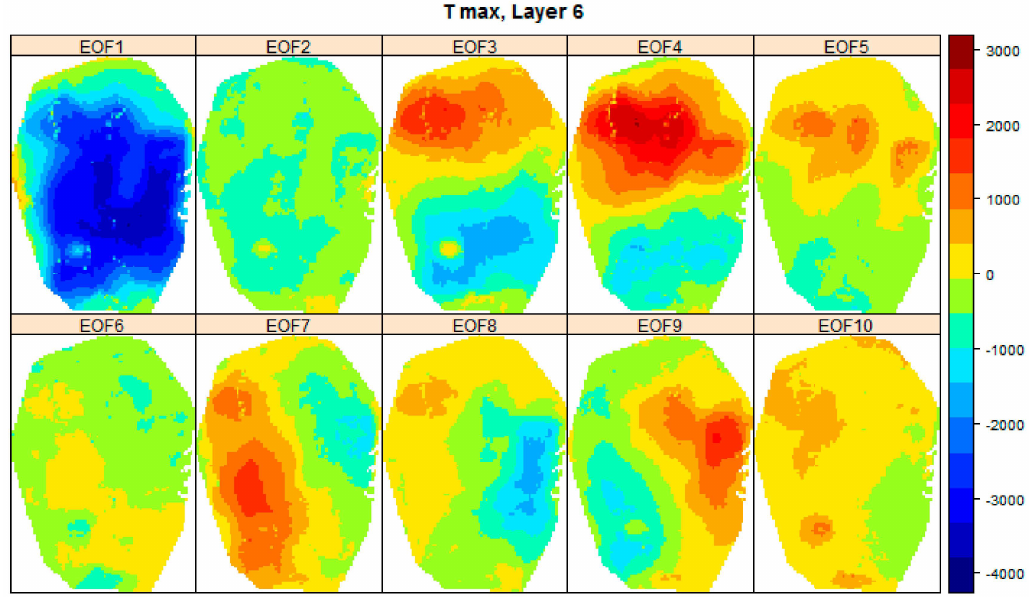
Figure 8. Spatial basis function for T-max in model layer 6. The subplots show the dominant 10 empirical orthogonal functions (EOF) that explain the greatest proportion of variability in the ensemble flow model